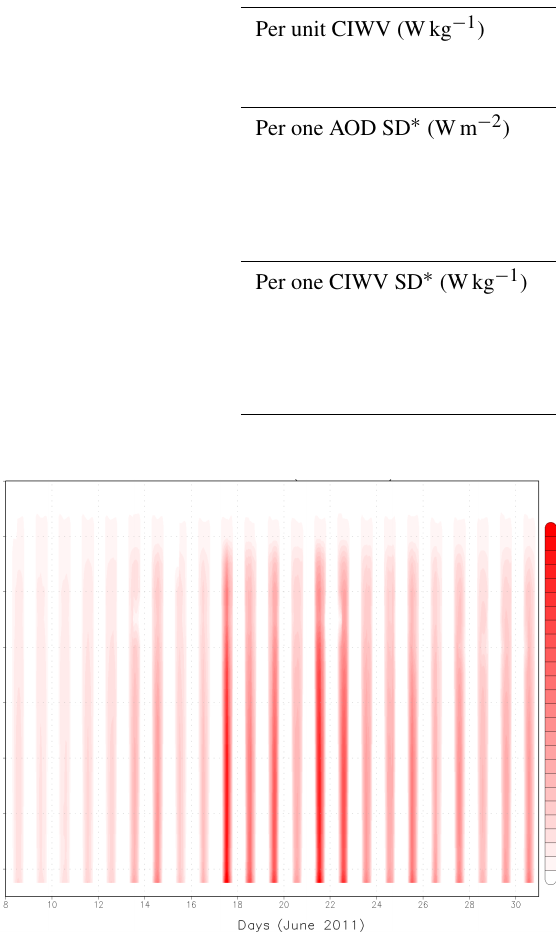
Figure 13. Shortwave radiative heating rates (Kday − 1 ) of dust in the atmosphere (wDnC minus